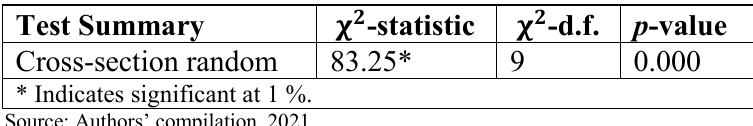
Table 4. The Result of Hausman